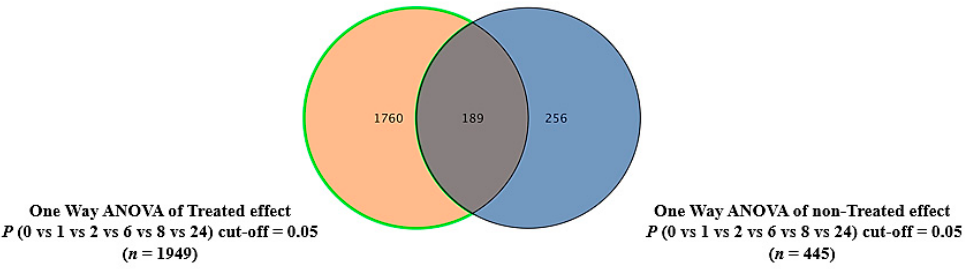
Figure 3. Excluded culture media backgrounds at the experimental time points. A Venn diagram showing the treated ( n = 1949) and non-treated ( n = 449) significant features at different time points (0, 1, 2, 6, 8, and 24 h). A group of 1760 features was consistently dysregulated 24 h post-treatment.